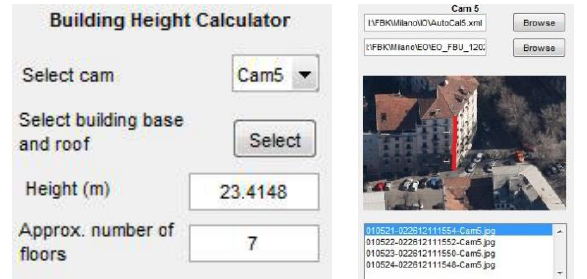
Figure 5. Additional feature to automatically retrieve the number of floors once the building height is determined.